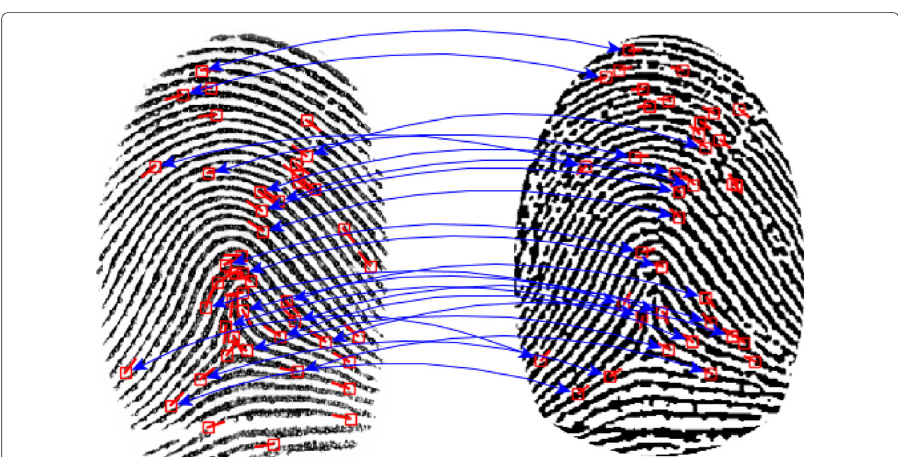
Fig. 7 Minutiae comparison. Manual comparison of minutiae of a touch-based fingerprint with a mirrored touchless